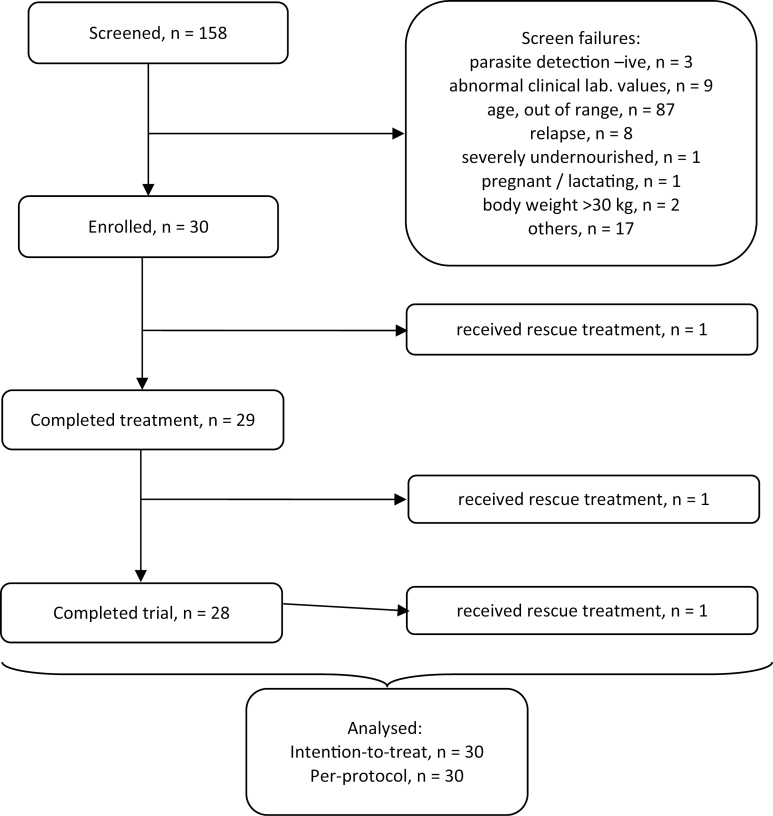
Disposition of patients.